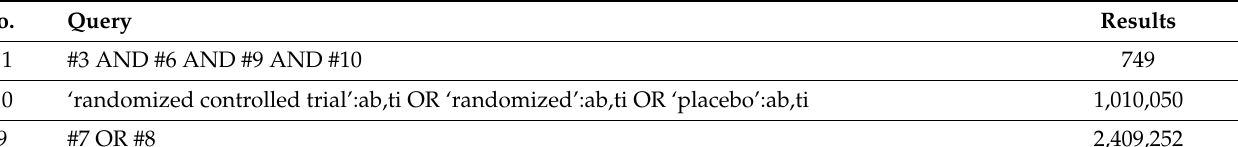
Table A3. Search content used for systematic search on evidence for the restorative benefits of exposure to green spaces on Embase database (updated on 6 December 2021).